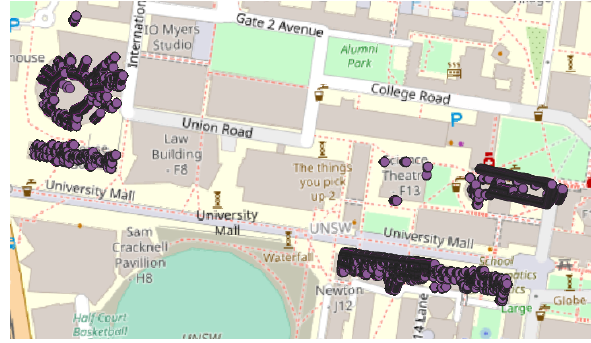
Figure 7. Visualisation of Eval-II via